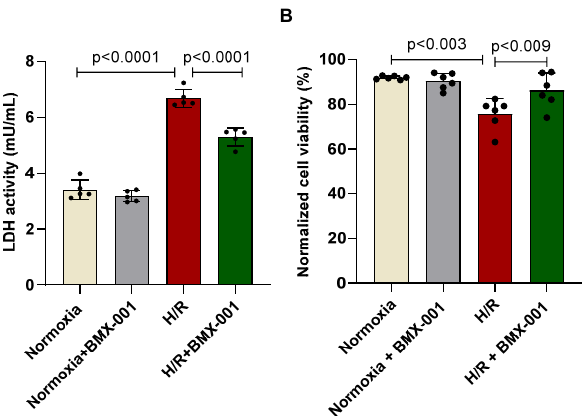
Figure 1. Treatment with redox regulator BMX-001 reduces H/R-induced H9c2 cardiomyocyte injury and cell death. ( A ) Following 24 h of reoxygenation, LDH activity in media was measured by assay kit. ( B ) Cell viability following 24 h of reperfusion was determined by using the trypan blue dye exclusion test. All values are mean ± SD. The p- value was used to determine statistical significance compared to the control group. Di ff erences between the two groups were analyzed by the two-tailed Student’s t -test and of more than two groups by one-way ANOVA with post-hoc Bonferroni Multiple Comparison test.